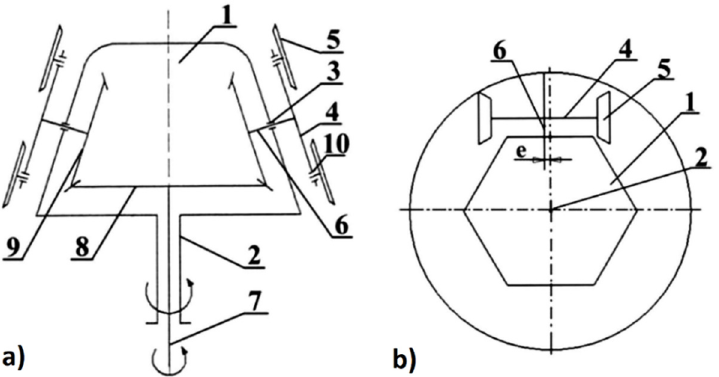
Figure 21. The scheme of the innovative solution of mining head with mini-disk tools of complex motion trajectory (description in the text): ( a ) kinematic diagram ( b ) top view [30].